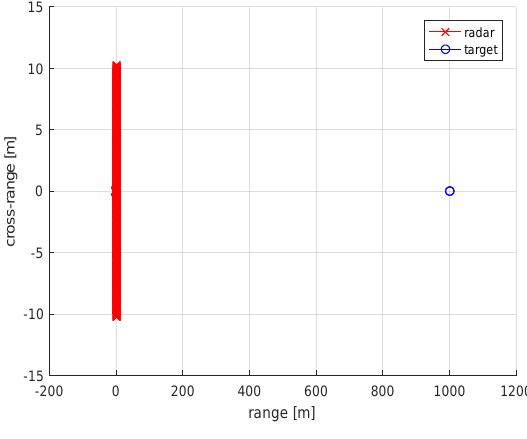
Figure 11. Collection